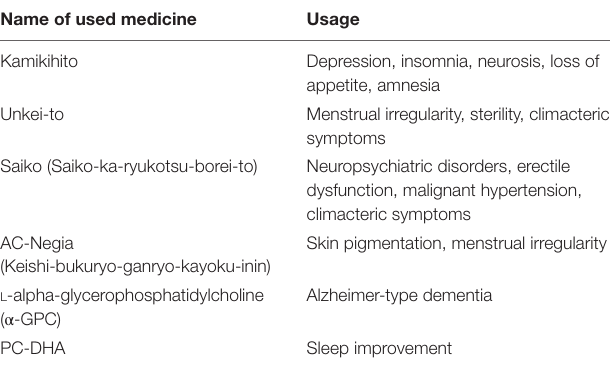
TaBle 1 | Summary of Kampo medicines used for the experiments. name of used